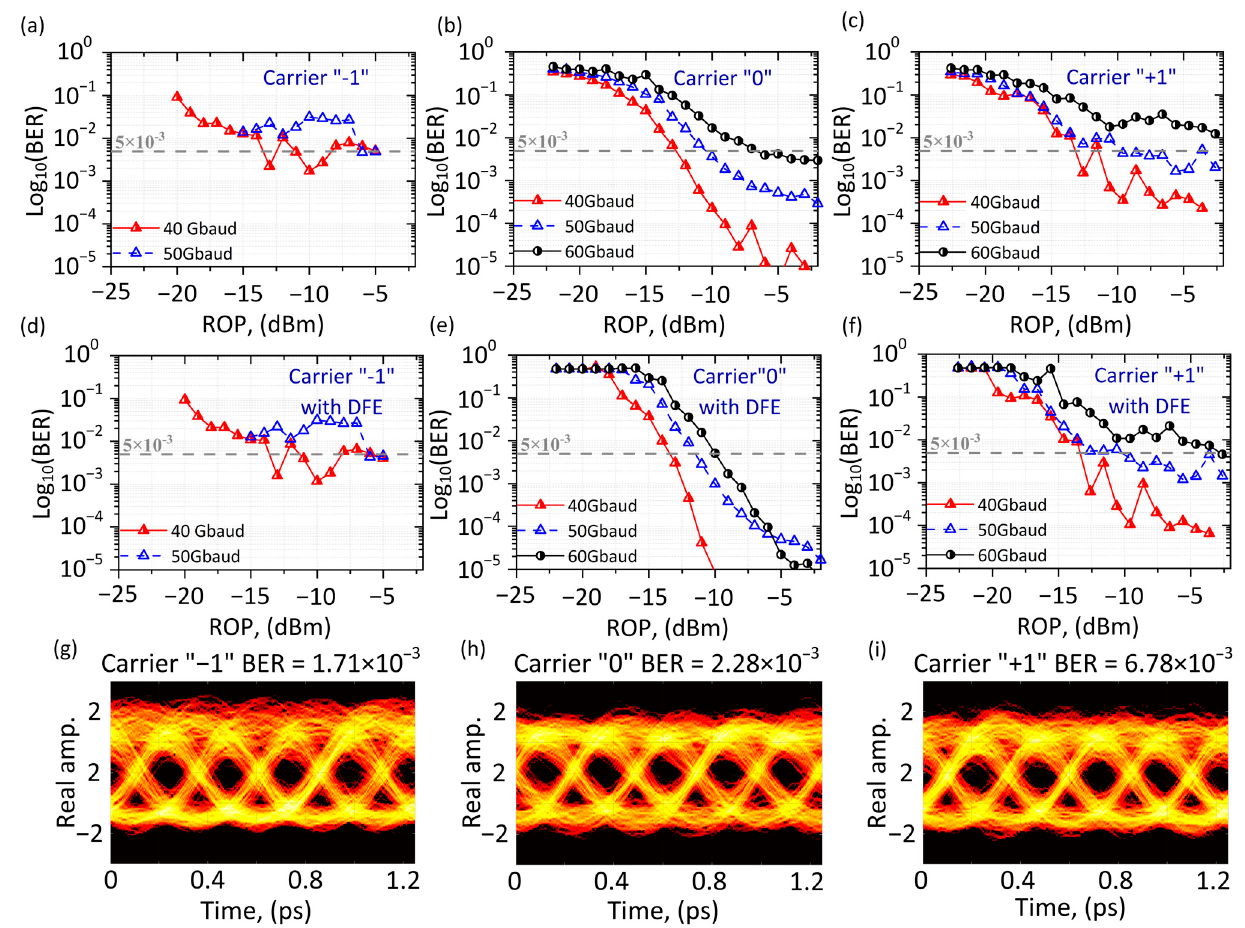
Figure 8. BER versus ROP for the IM/DD communication system where the Kerr-OFC light source carriers “ − 1”, “0”, and “+1” can be used for NZR-OOK signals transmission with baud rates up to ( a ) 50 Gbaud, ( b ) 60 Gbaud, and ( c ) 50 Gbaud without any post-equalization. If the post-equalizer with 33-FF and 15-FB taps is used, the BER is signi fi cantly improved for carriers “ − 1”, “0”, and “+1” up to ( d ) 50 Gbaud, ( e ) 60 Gbaud, and ( f ) 60 Gbaud. Received signal eye diagrams for carriers: ( g ) “ − 1”, ( h ) “0”, and ( i ) “+1” captured at ROP of − 10 dBm in the 40 Gbaud case.